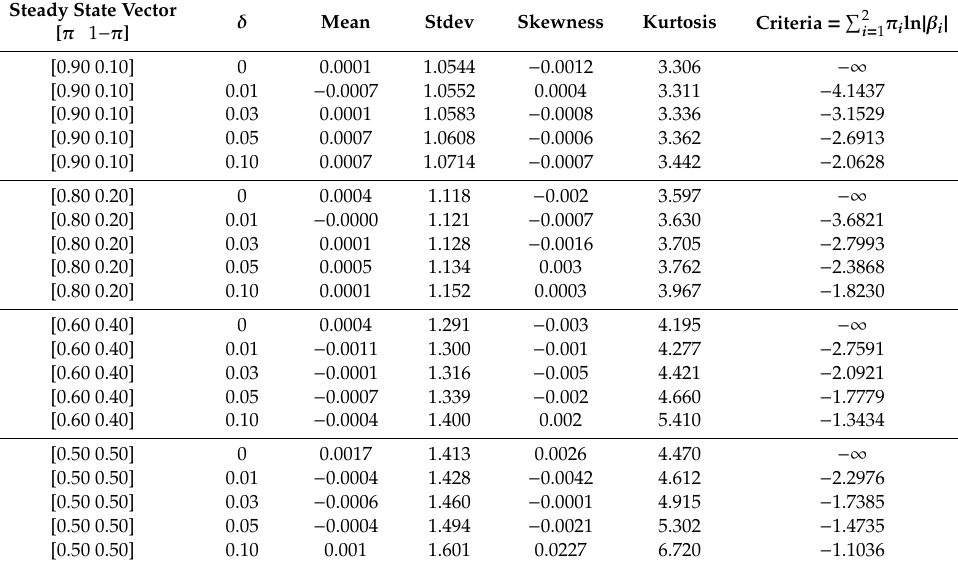
Table 2. Average moments of TAR(1) with changing Steady State